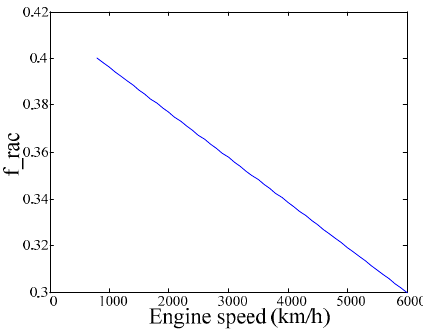
Figure 5. The estimated value of the parameter f_rac.